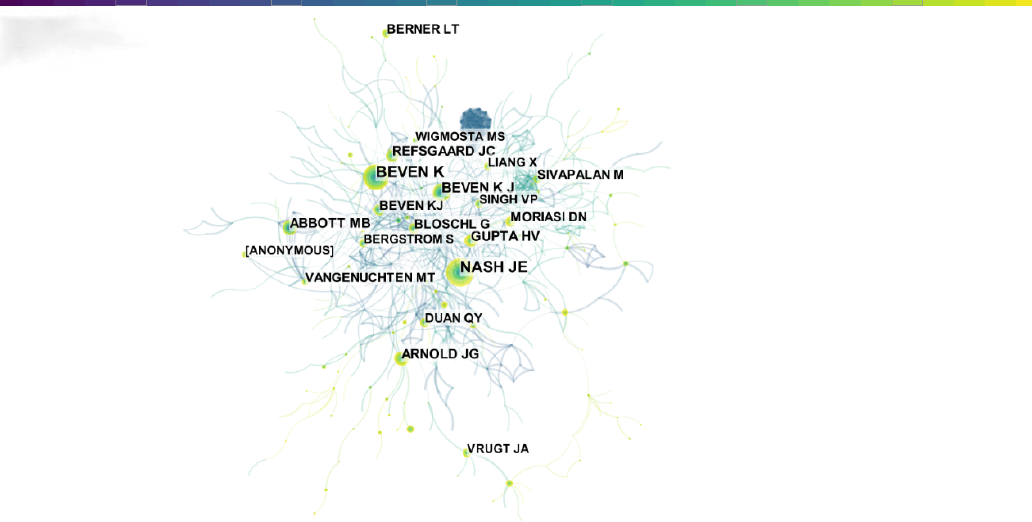
Figure 6. Author co-citation map.